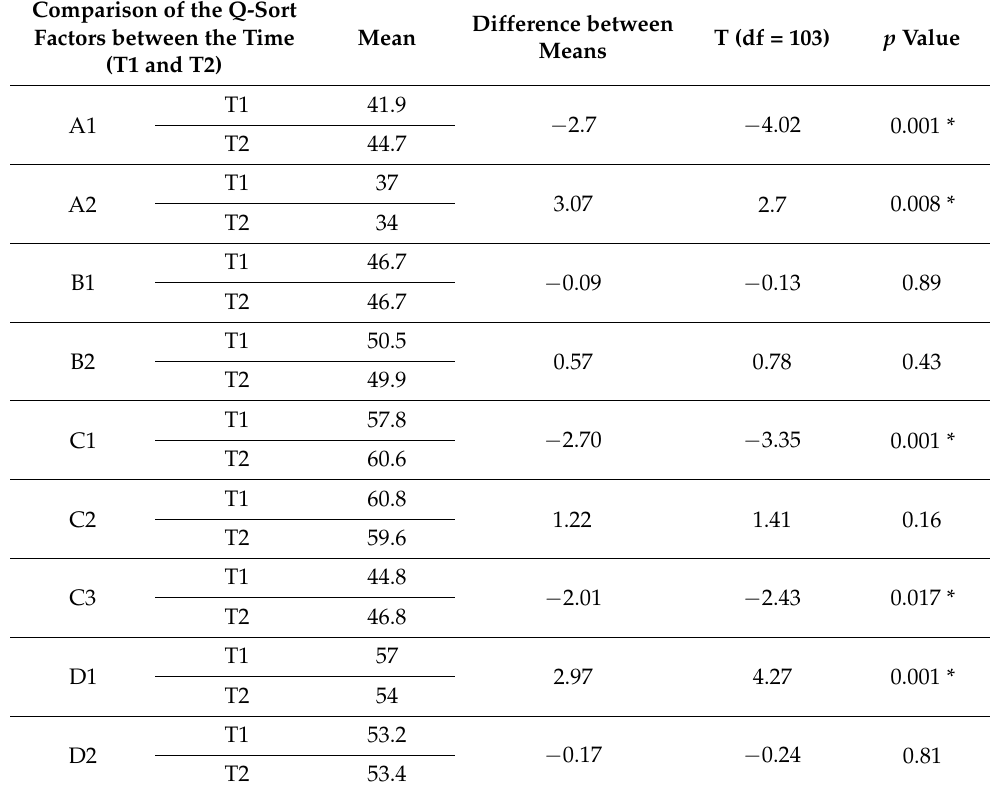
Table 4. Factors of the Q-Sort and differences between T1 and T2 (paired sample t -test) ( n = 104). Comparison of the Q-Sort Factors between the Time (T1 and T2)